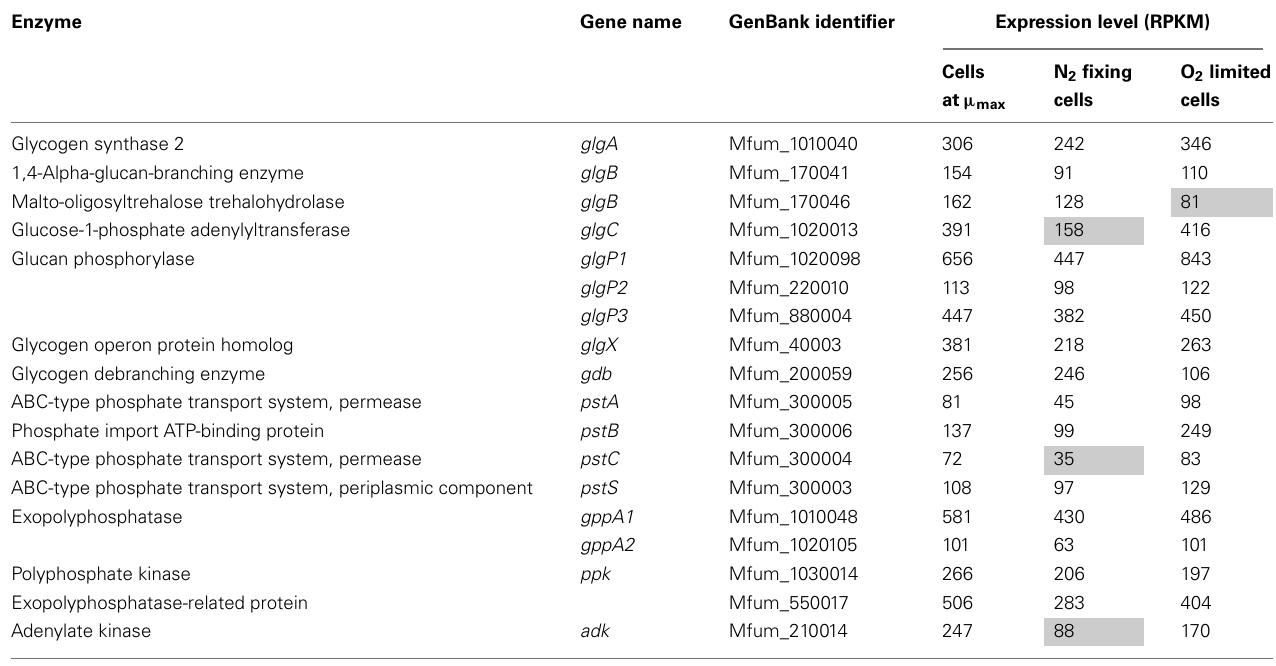
TableA3 |Transcription of genes involved carbon and energy storage in “ Ca. M. fumariolicum ” strain SolV.